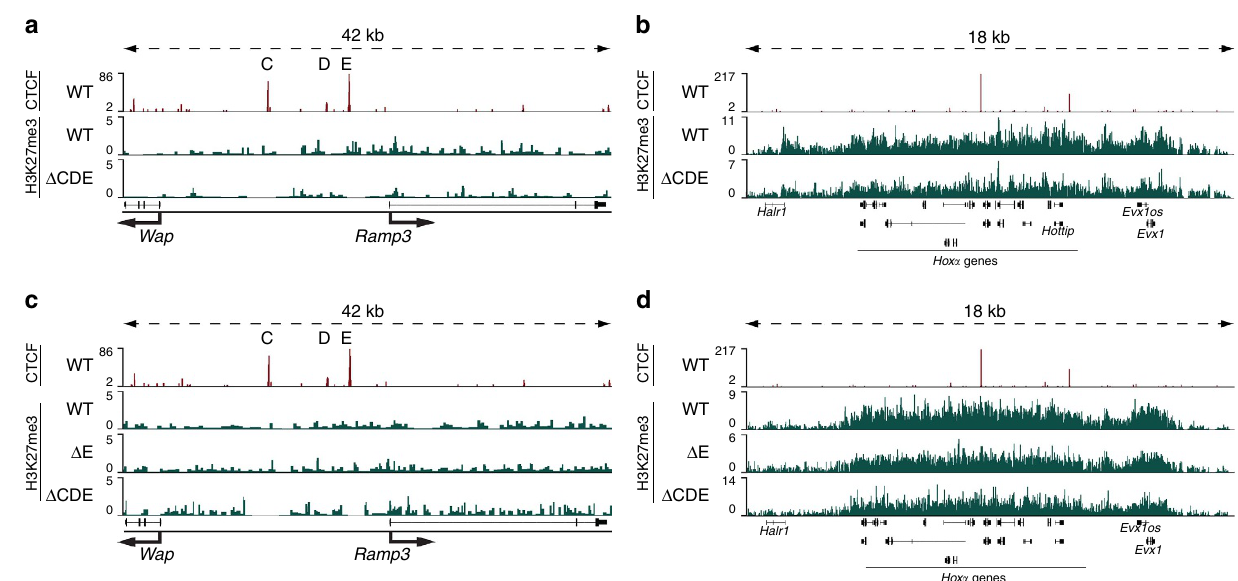
Figure 9 | Absence of K3K27me3 marks in the Wap-Ramp3 locus in mammary tissue and cerebellum. ( a ) H3K27me3 marks were virtually absent in the Wap - Ramp3 locus in mammary tissue from WT and D CDE mutants. ( b ) The Hox a locus served as a control locus and showed extensive H3K27me3 coverage in mammary tissue. ( c ) No increase of H3K27me3 marks in D E and D CDE mutants in the cerebellum. ( d ) The Hox a locus served as a control locus in the cerebellum and showed strong H3K27me3